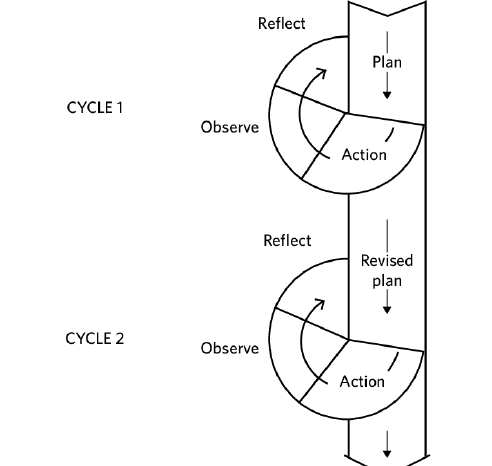
Figure 1 . Kemmis and McTaggart AR